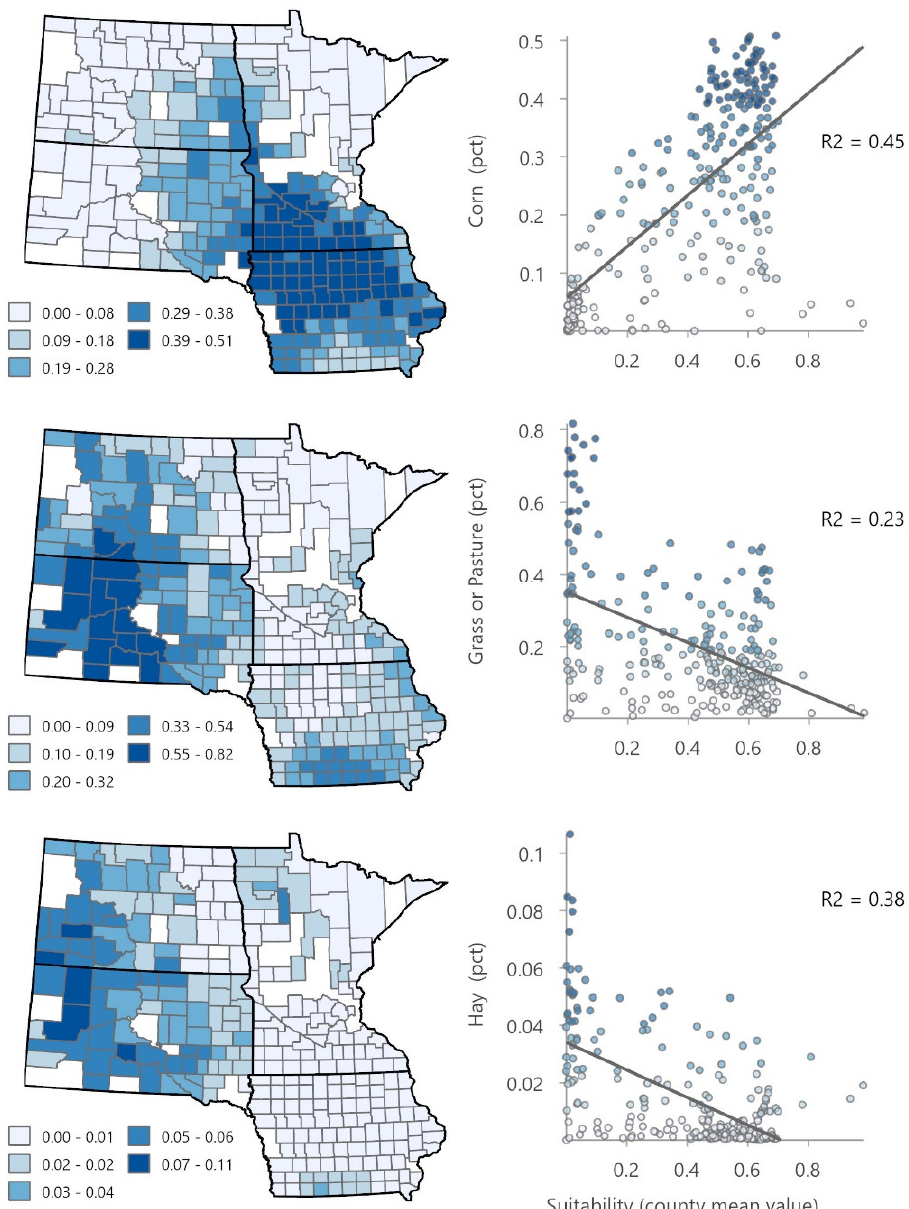
Figure 4. Distribution of corn ( top ), grassland + pasture ( center ), and hay ( bottom ), aggregated by county ( left ), and plotted against county mean suitability value ( right ). Values are given as a fraction, where total land cover = 1.0.